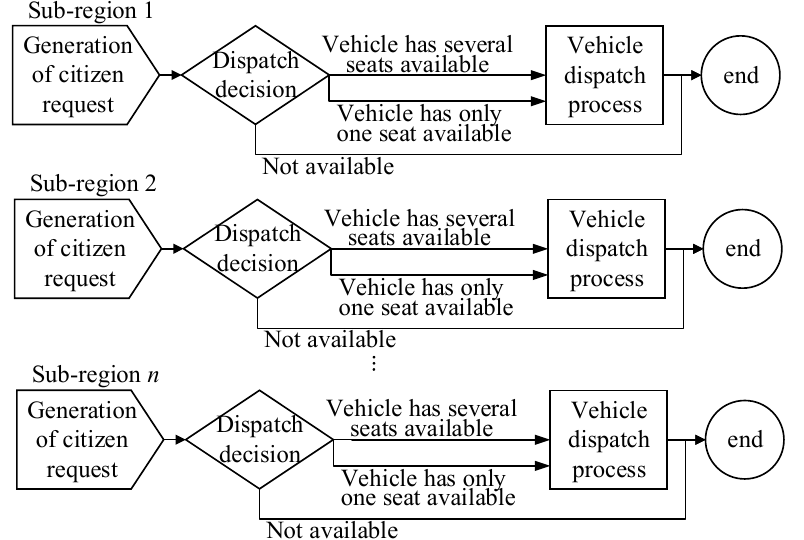
Figure 10. Arena environment setup where each sub-region has its own process modules with similar structures.